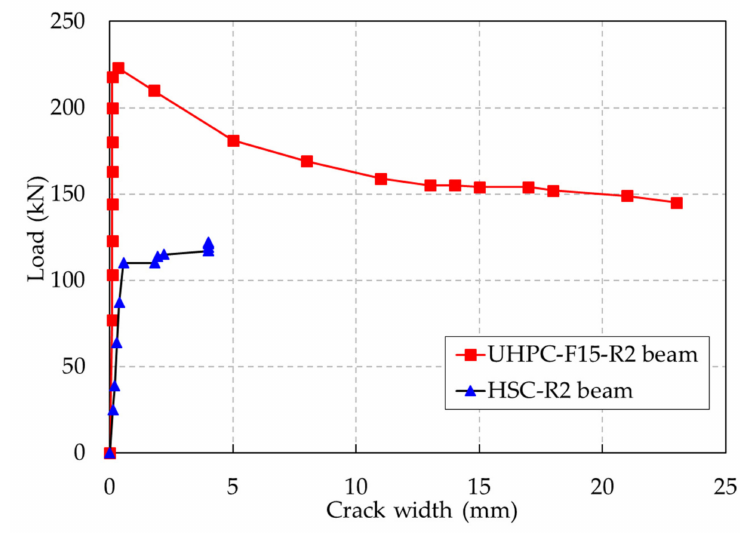
Figure 8. Comparison of the evolution of the crack width until failure of the UHPC and HSC beams.